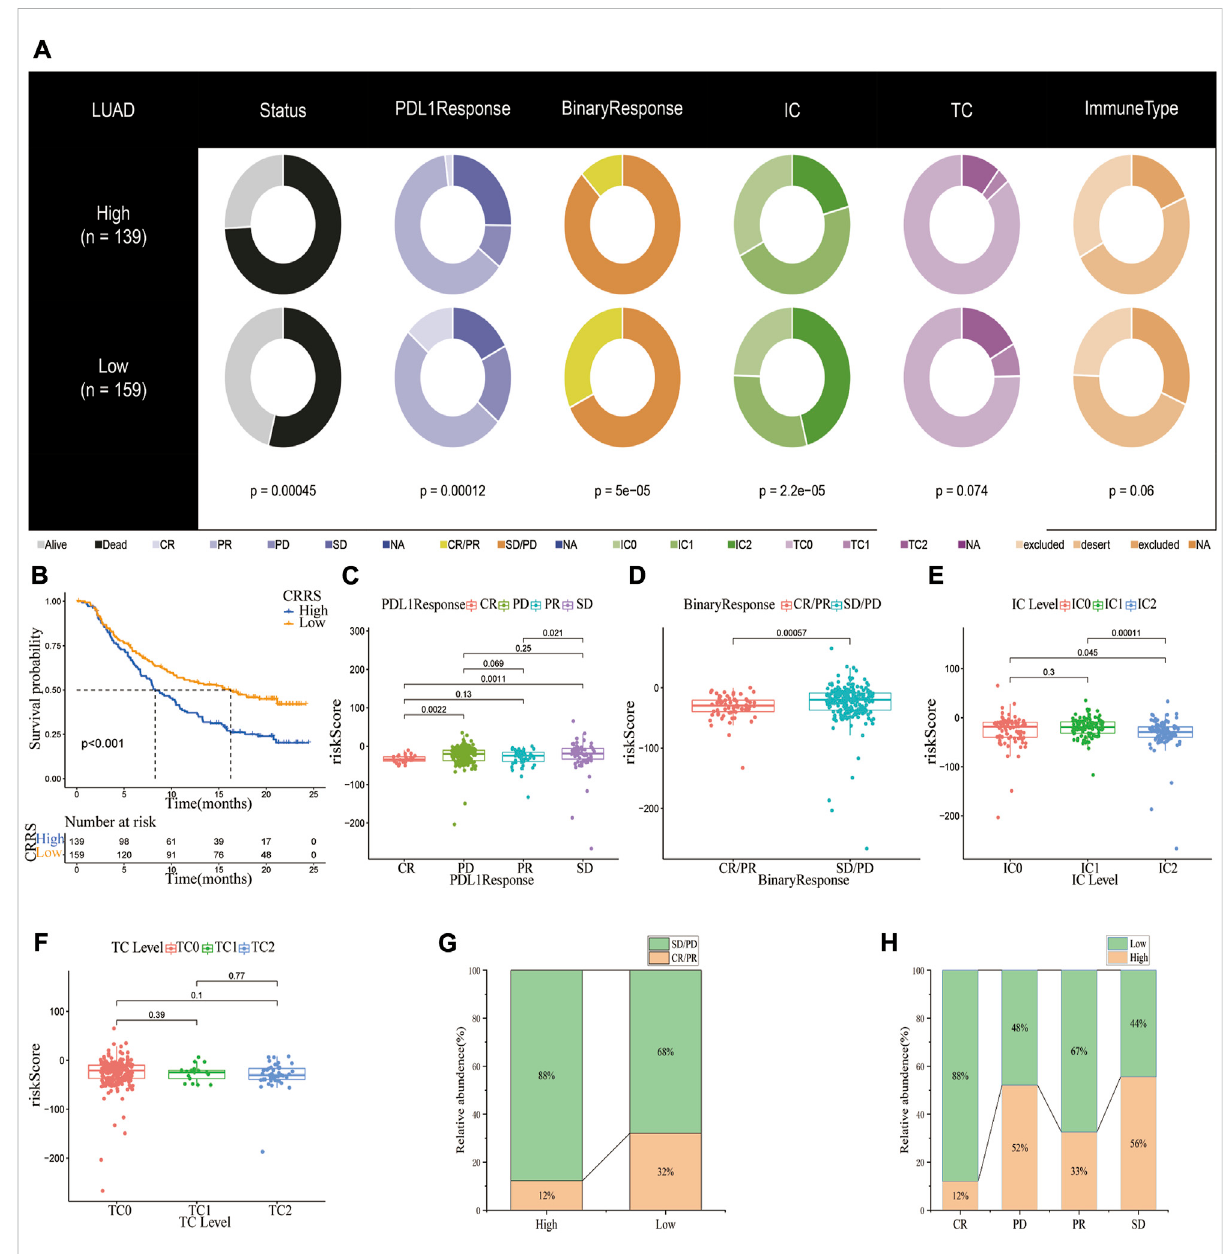
FIGURE 8 The potential of CRG_score signature in anti-PD-1/L1 immunotherapy. (A) Distribution of clinical characteristics among high and low CRG_scoregroupsintheIMvigor210cohort. (B) Kaplan-MeierplotshowingthedifferenceinoverallsurvivalindifferentCRG_scoresubgroups. (C,D) The risk scores in patients with CR/PR or CD/SD (PR, Partial Response, PD, Progressive Disease; SD, Stable Disease, and CR, Complete Response). In the IMvigor210 cohort, the difference in CRG_score between PD-L1 expression of various (E) IC and (F) TC. (G) Proportions of anti-PD- L1 immunotherapy response in different CRG_score groups. (H) The proportion of patients having a high or low-risk score in various responses to anti-PD-L1